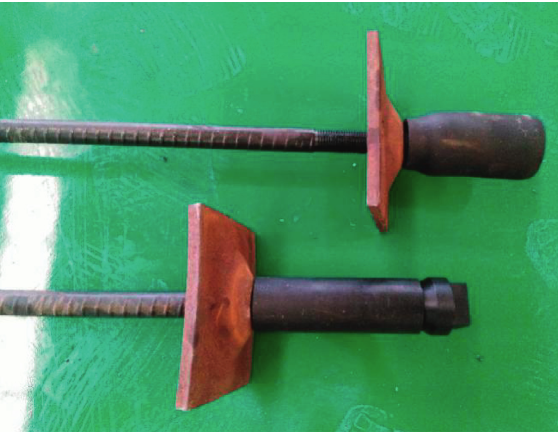
Figure 9: 300kN test bench.